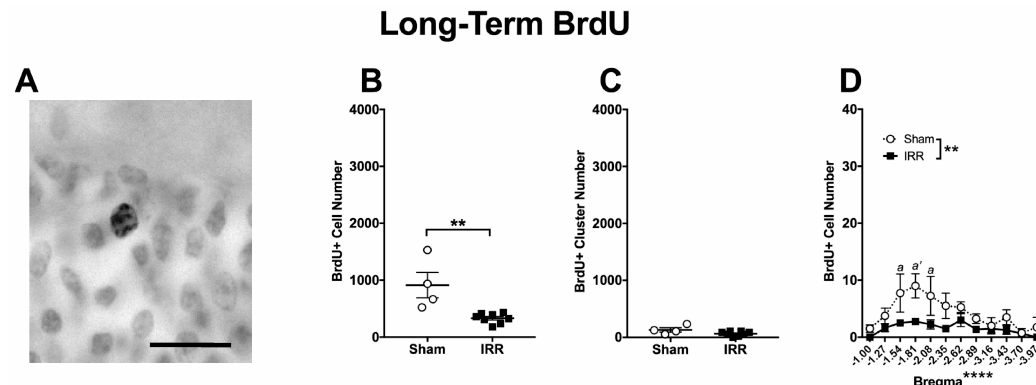
Figure 7. Three-mon post- 12 C irradiation, there were fewer DG GCL BrdU+ cells in IRR mice relative to Sham mice. ( A ) Representative photomicrograph of BrdU staining in a Long-Term Sham mouse (mouse #13853; 400 × , scale bar = 25 µ m). ( B ) An unpaired t -test revealed fewer BrdU+ cells in IRR mice versus Sham mice (** p < 0.01; N = 4 Sham, N = 8 IRR). ( C ) An unpaired t -test revealed similar number of BrdU+ clusters in IRR and Sham mice ( p > 0.05). ( D ) Bregma analysis of BrdU+ cells through two-way ANOVA (Bregma × Treatment) revealed a main effect of Treatment ( F 1,10 = 14.31; ** p < 0.01) and Bregma ( F 11,110 = 5.964; **** p < 0.0001), but no significant interaction ( F 11,110 = 1.775; p > 0.05). Post-hoc (Sidak’s multiple comparison) test revealed fewer BrdU+ cells at bregma positions − 1.54 ( a p < 0.05), − 1.81 ( a’ p < 0.01), and − 2.08 ( a p < 0.05) in IRR mice relative to Sham mice. Error bars ±